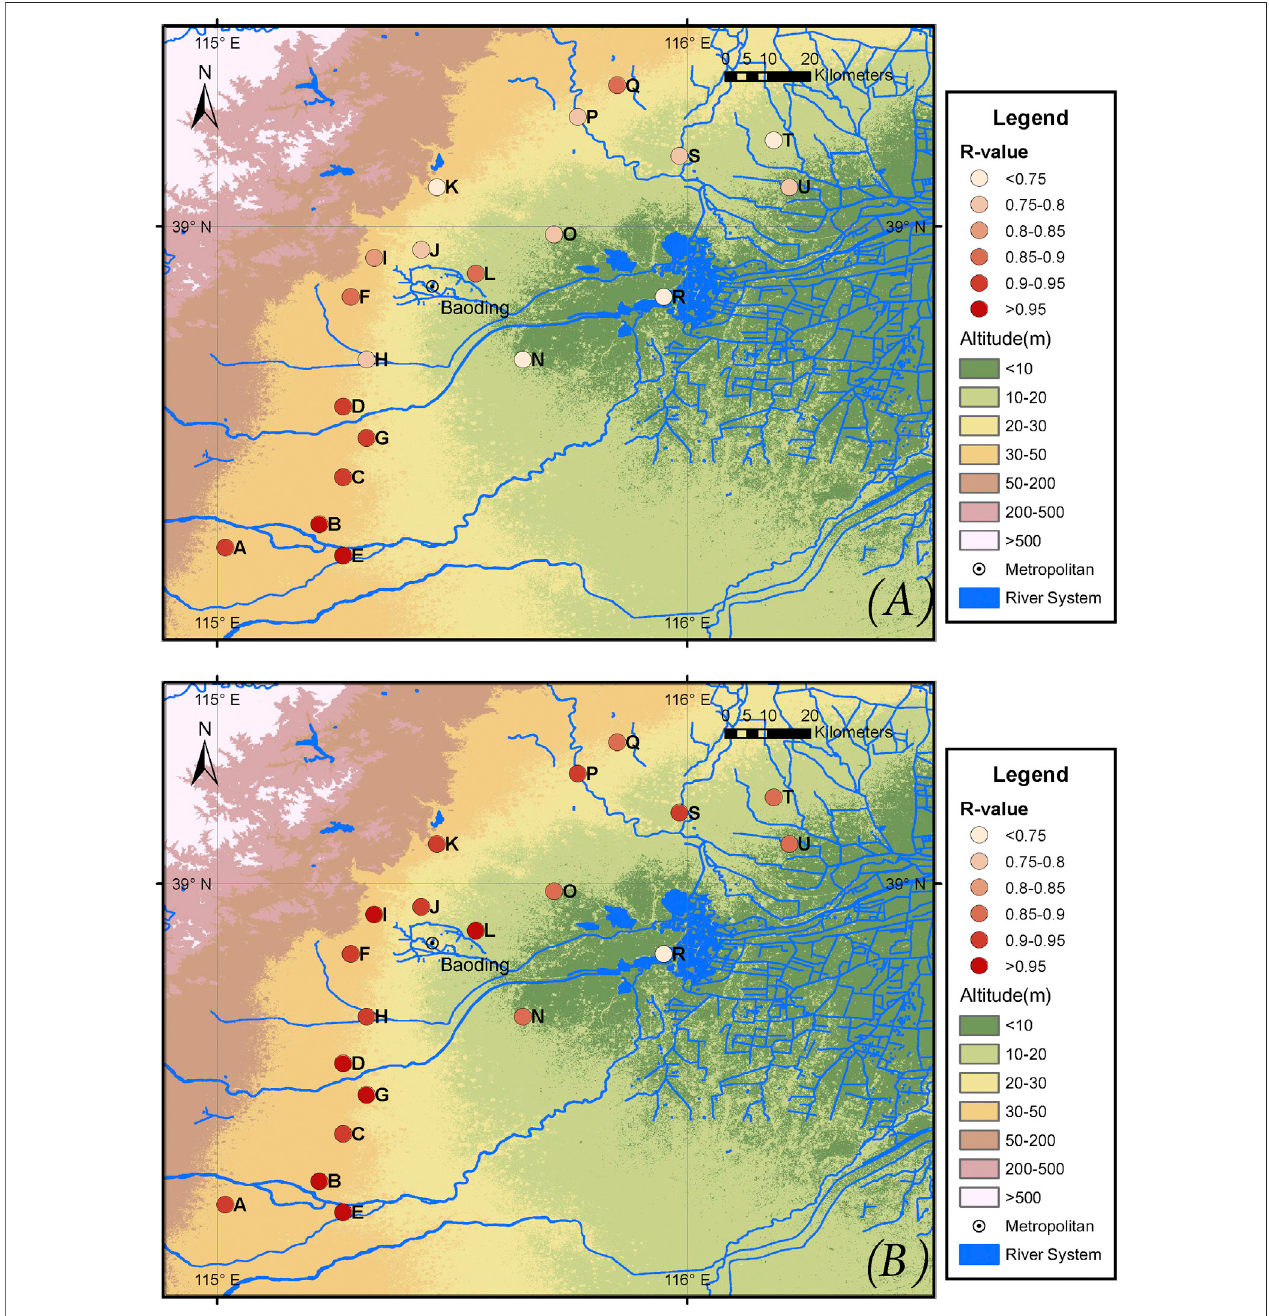
FIGURE 8 | Spatial distribution of R values using LSTM model and wavelet-LSTM model during the testing period: (A) LSTM (B) wavelet-LSTM.